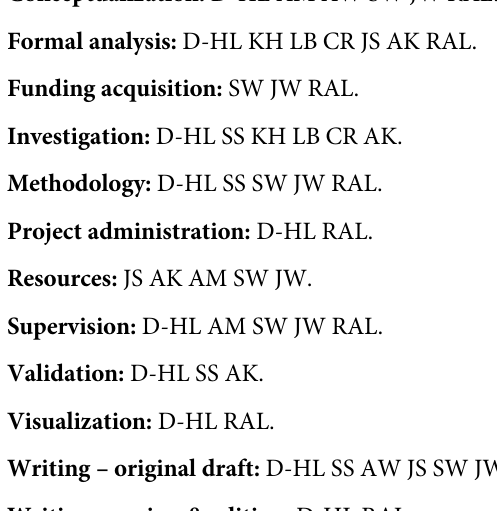
S1 Fig. Representative images of spinal cord cross sections. (A,B) After staining for CD3 (T cells), (C,D) Mac-3 (macrophages/microglia), (E,F) demyelination (Luxol Fast Blue), (G,H) activated astrocytes (GFAP), and (I,J) axons (Bielschowsky silver impregnation). Controls are shown on the left; fingolimod treatment is displayed on the right side of the panel. Bar 500 µµm in E,F and 100 µm for all others. Arrows denote demyelinated lesions or labelled cells.